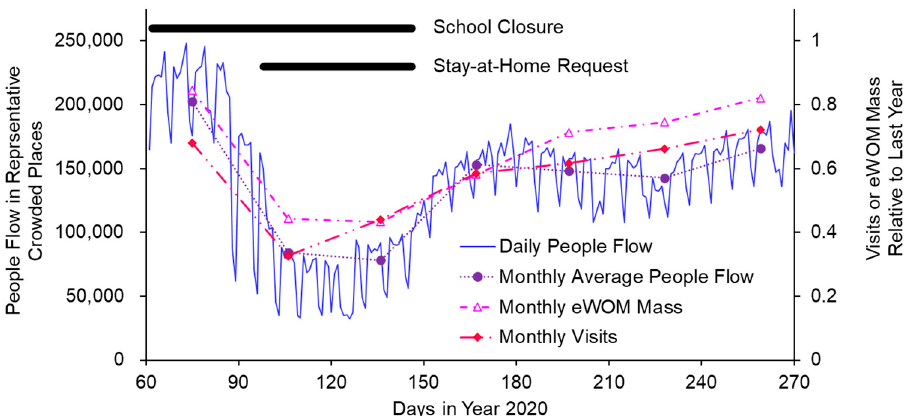
Figure 2. People flow represented by the number present at 18:00 on weekdays, when there is typically a peak around and within Shinjuku Station (500-m radius from the station center) in the Tokyo Metropolitan area (left y -axis); customer visits and electronic word-of-mouth (eWOM) mass (right y -axis), recorded in 2020. Data were collected via smartphone location information, integrated web-based eWOM, and restaurant reservation services.